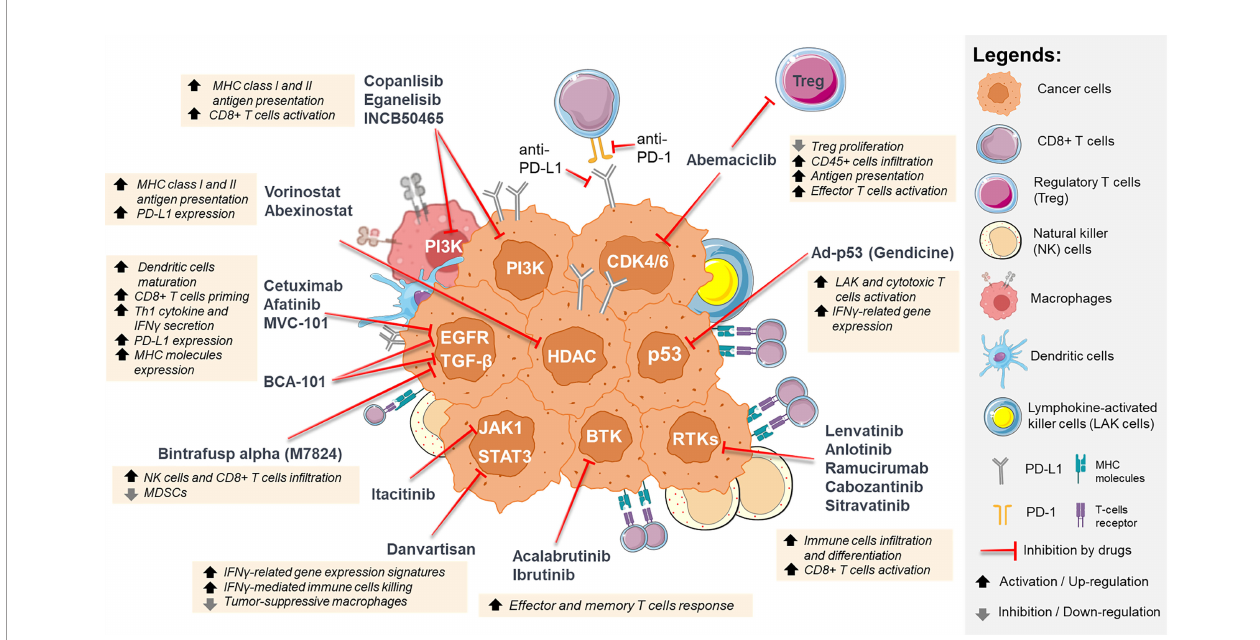
FIGURE 1 | Summary of the immunomodulatory effects of inhibiting oncogenic signaling pathways in HNC. These targeted agents not only result in tumor-intrinsic killing, but also modulate the tumor microenvironment, such as increasing immune cell in fi ltration, activation and differentiation, increasing MHC class I and II antigen presentation, increasing PD-L1 expression, and inhibiting regulatory T cells proliferation. *For illustration purpose only, icons are not drawn in actual scale ratio. ** Some icons are taken from Servier Medical Art